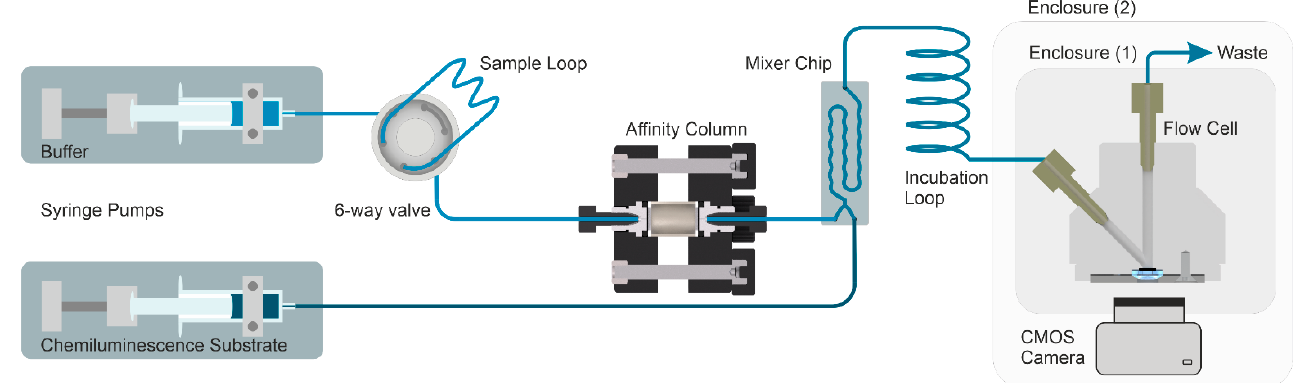
Figure 4. Micro fl uidic setup for the detection of cardiac troponin I (cTnI). The sample injection was performed by a 6-way valve and a continuous fl ow of running bu ff er and chemiluminescence substrate. After passing the peptide–BSA a ffi nity column, the sample and substrate were combined 1:1 inside a mixer chip. This was followed by an incubation loop for preincubation and the fl ow cell for optical detection.